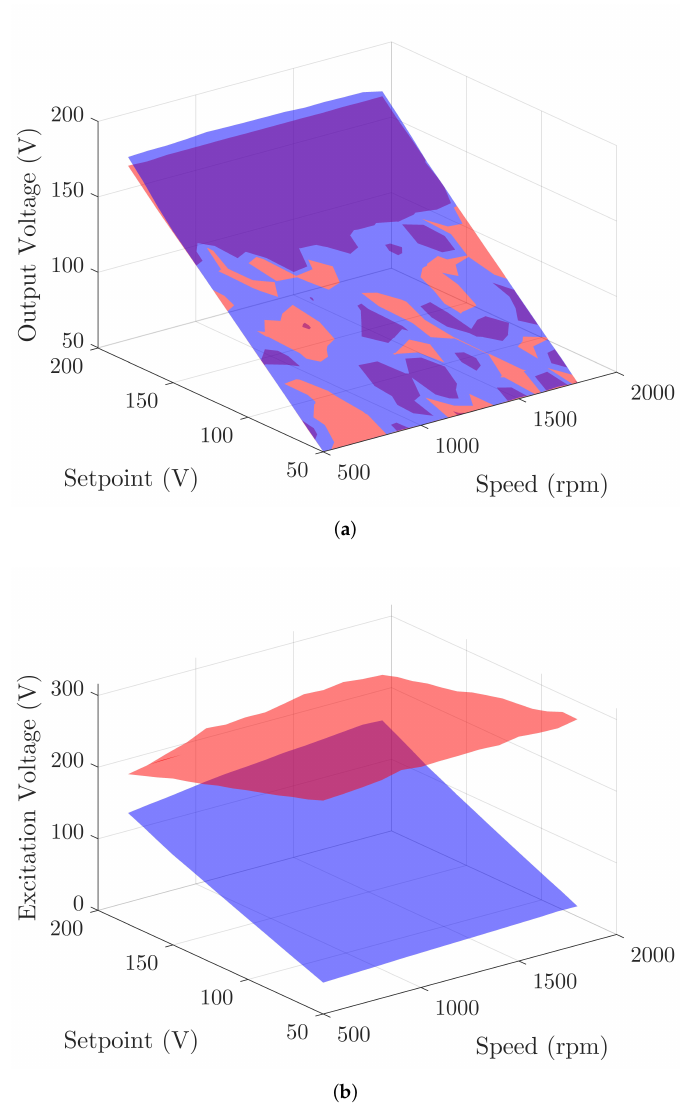
Figure 11. Output voltage surfaces for the implemented PID controllers and excitation voltage applied to the SRG for each controller (blue surface: PID controller acting on the excitation voltage, red surface: PID controller acting on the turn-off angle): ( a ) SRG output voltage and ( b ) SRG excitation voltage applied by the PID